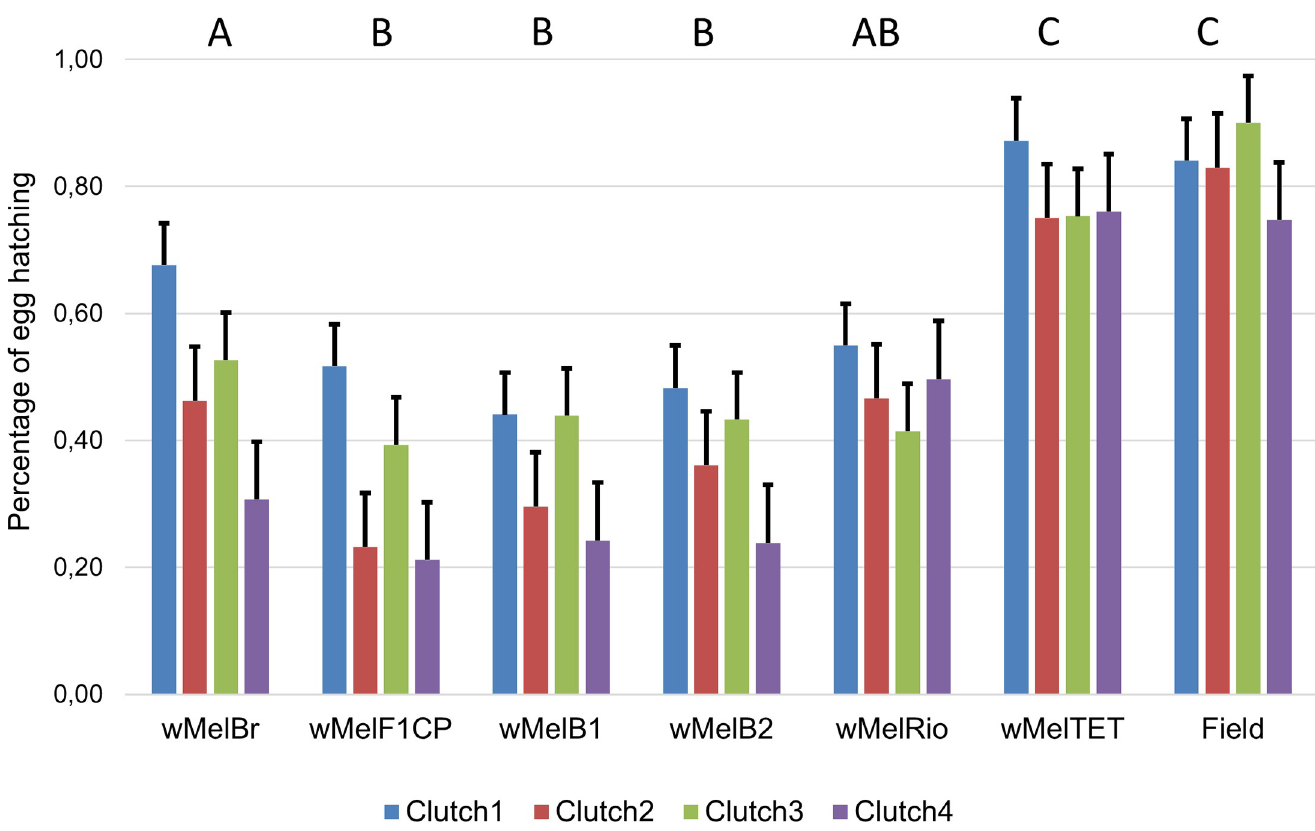
Fig 5. Mean and standard deviation of Aedes aegypti egg hatching during the first four clutches of the seven populations from the backcrossing. Different letters indicate significant differences on egg hatch